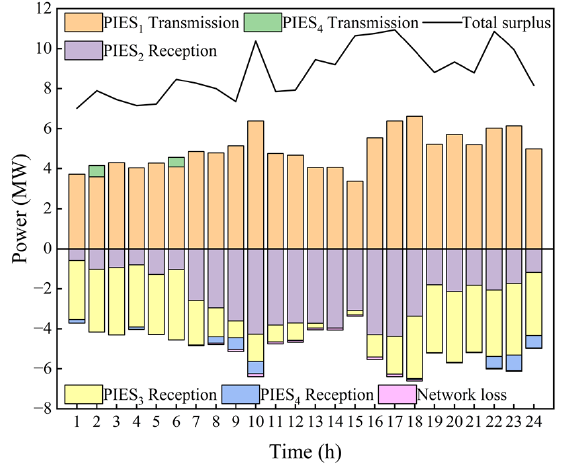
Figure 11. RIESG power interaction.